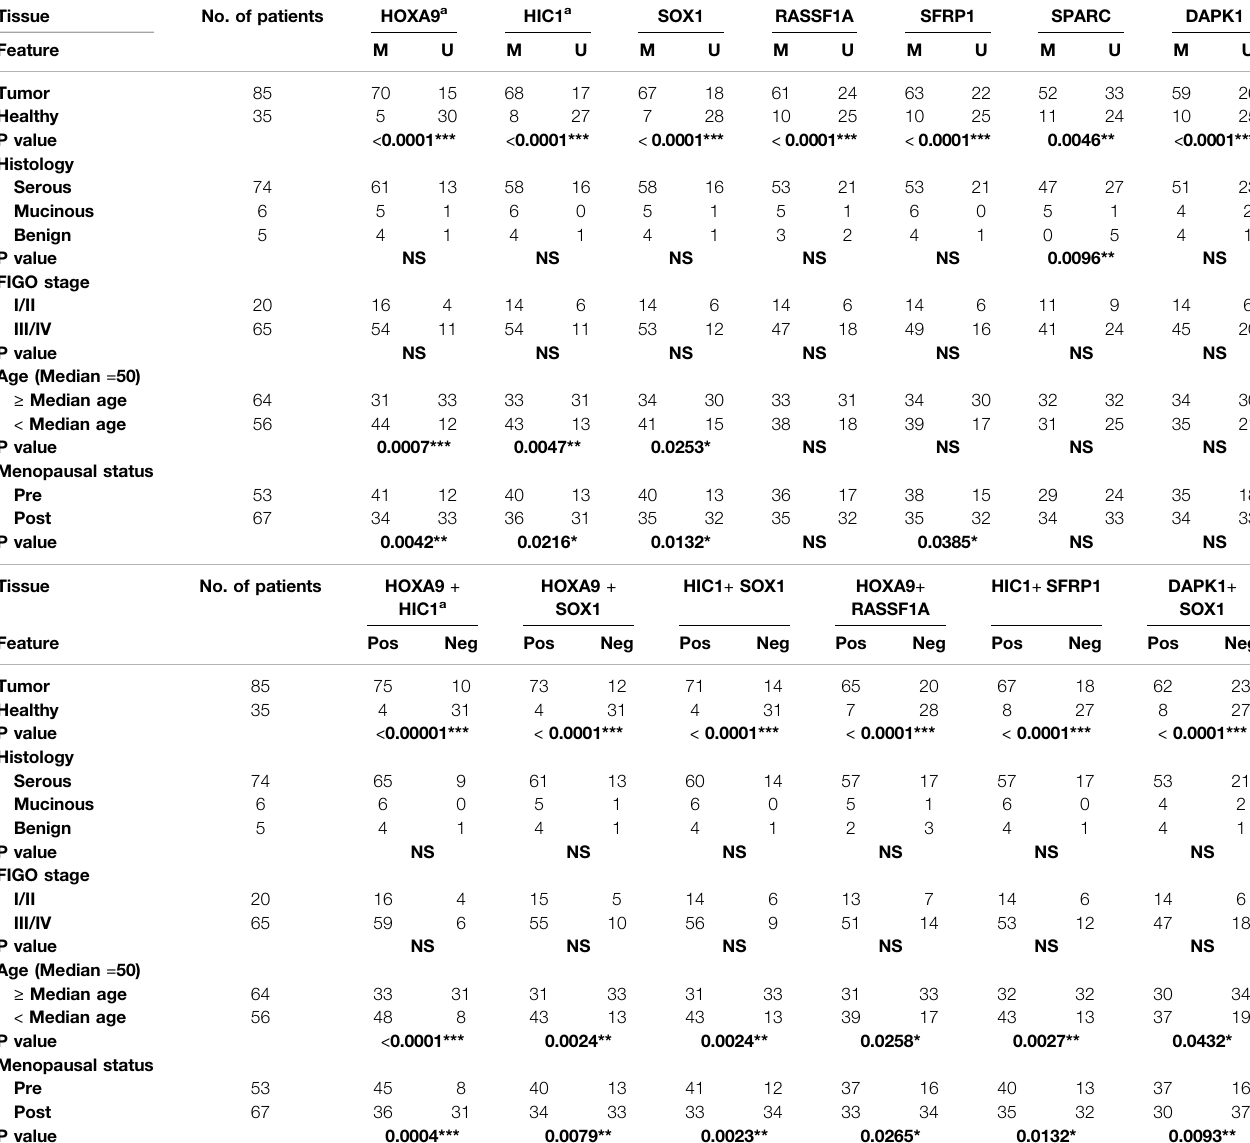
TABLE 4 | Association of promoter hypermethylation status of candidate genes with patient ’ s clinico-pathological features in EOC tissue samples. p -value: Pearson ’ s chi- squareandFisher ’ sexacttests.Abbreviation:Pos:biomarkerpanelpositiveformethylation;Neg:biomarkerpanelnegativeformethylation;NS:notsigni fi cant.Apositive biomarker panel is de fi ned as when either or both gene promoter show methylation. Tissue No. of patients